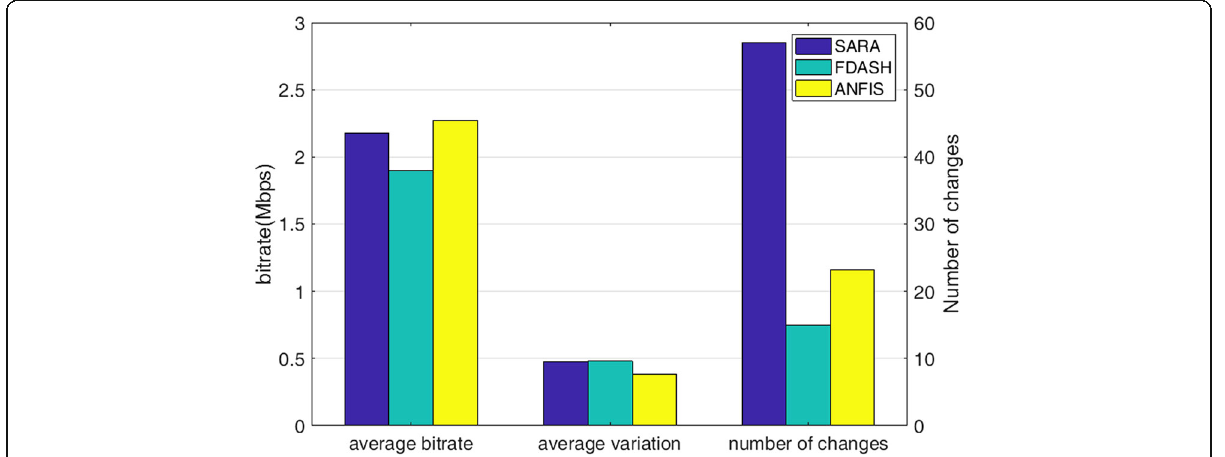
Fig. 11 Performance of each element of QoE in the second Wi-Fi